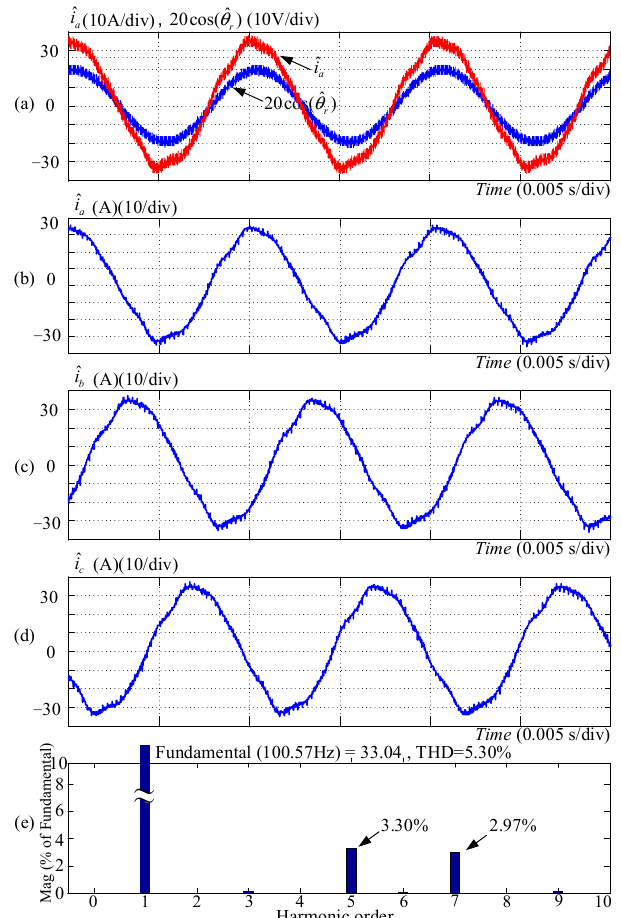
Figure 7. Measured phase currents of a three-phase permanent-magnet synchronous motor driven at 1500 rpm without compensation for harmonic components in induced EMF: ( a – d ) measured phase currents ˆ i a , ˆ i b and ˆ i c ; ( e ) spectrum of phase current ˆ i a .